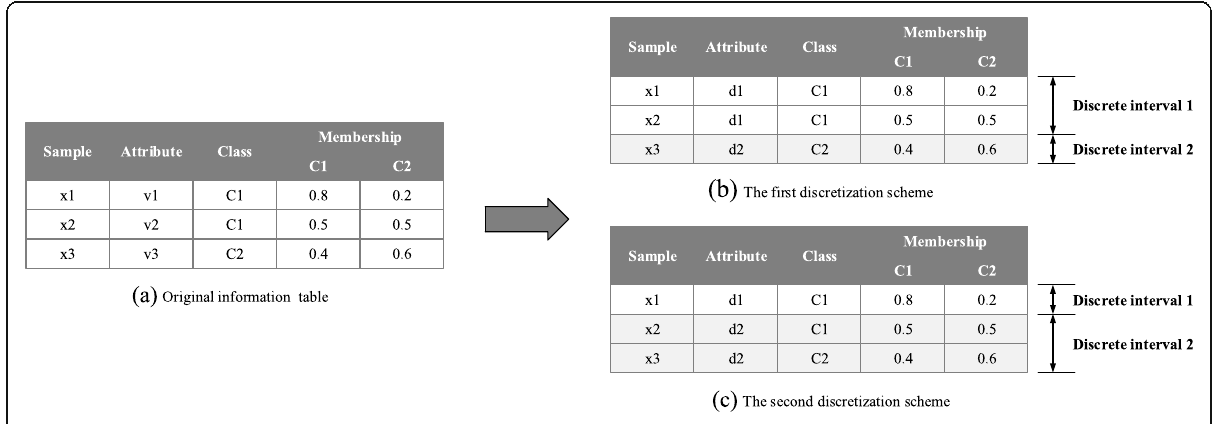
Fig. 3 A simple example illustrating that RFMD has advantages over rough set-based discretization